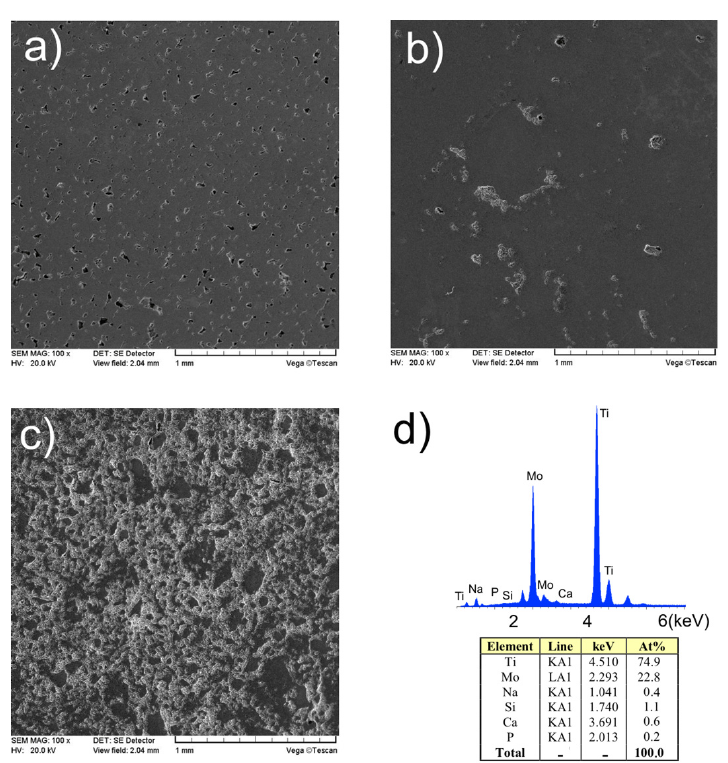
Figure 3. Scanning electron microscopy (SEM) micrographs of Ti23Mo alloy ( a ); Ti23Mo 3BG ( b ) and Ti23Mo 10BG nanocomposites ( c ); Energy dispersive spectroscopy (EDS) analysis of the surface of sintered Ti23Mo 3BG nanocomposite is shown in ( d ).